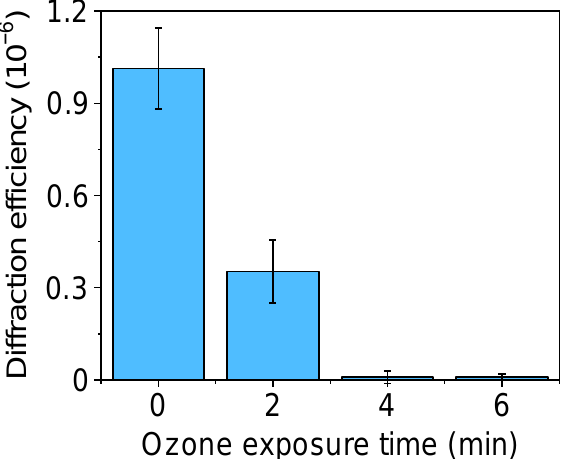
Figure 4. Diffraction efficiency of protein patterns fabricated by µCP on glass, with PDMS stamps treated by different UV-ozone exposure times before the inking.